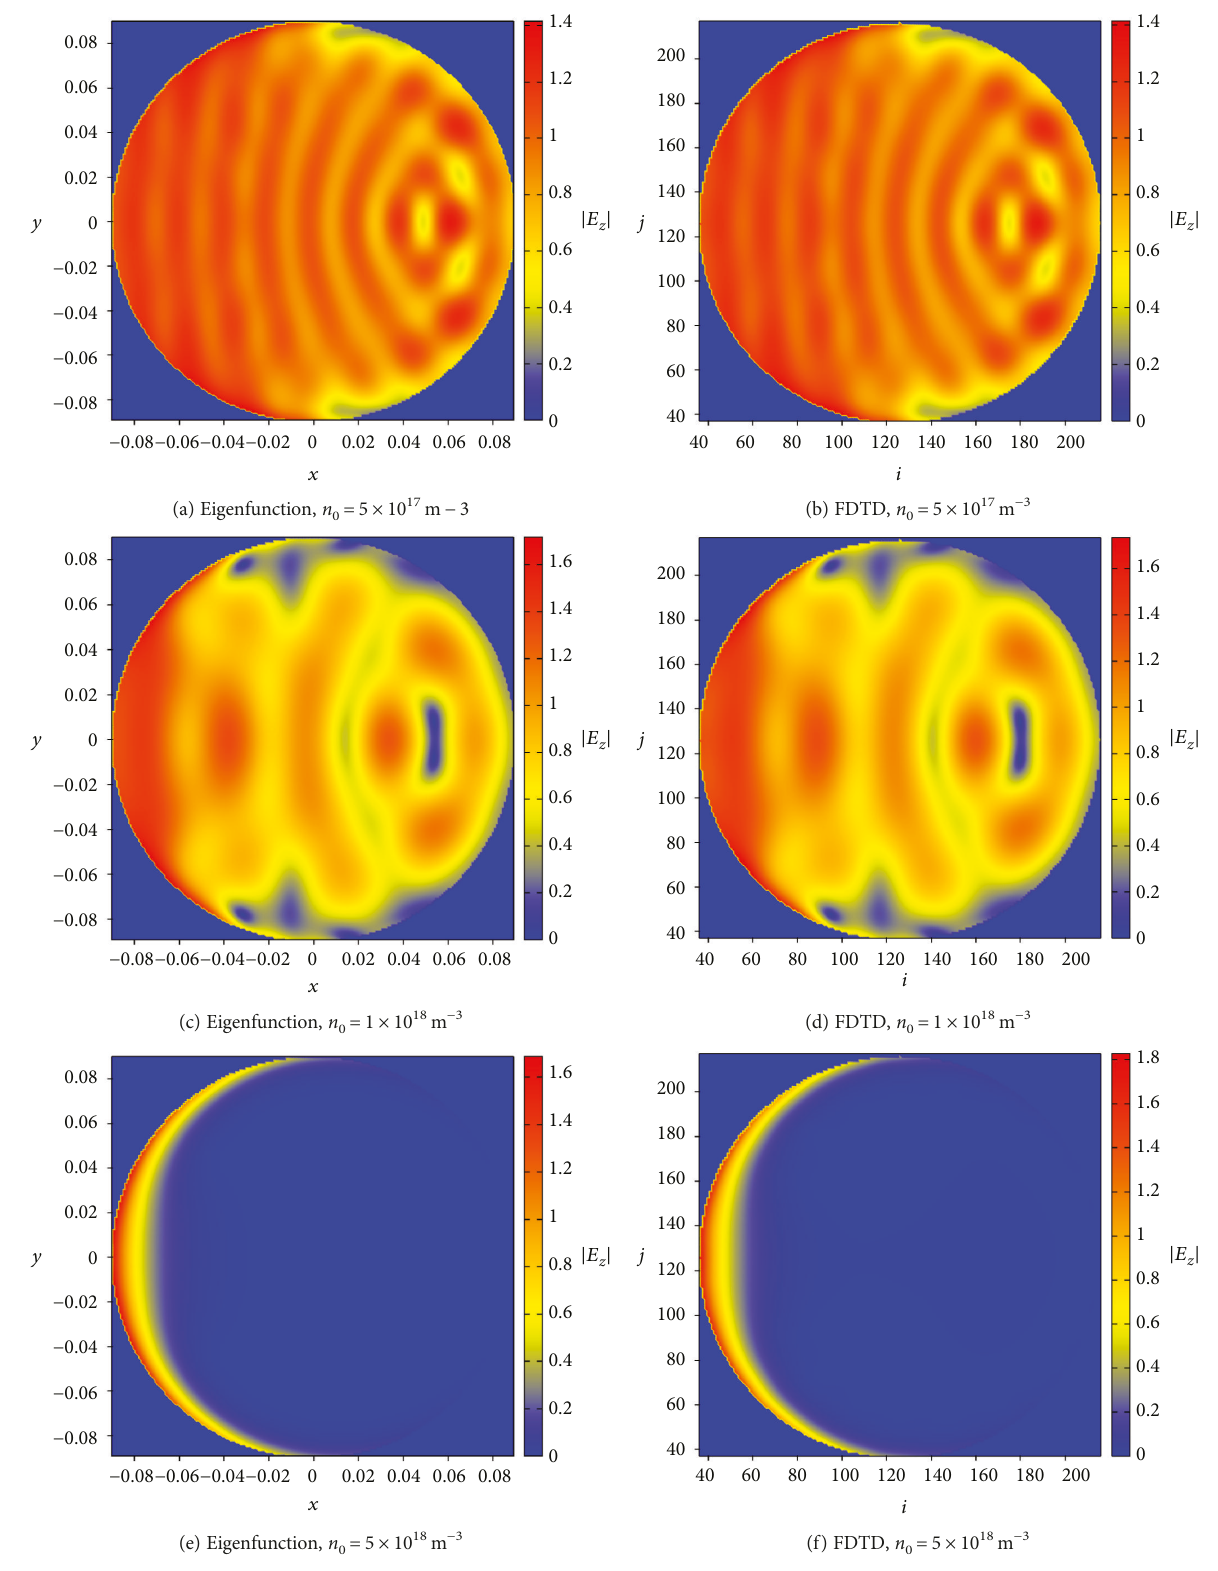
Figure 7: Comparison between the magnitude of the electric fi eld, in volts/meter, within the cylinder obtained by the eigenfunction method and the FDTD simulation for di ff erent electron densities; incident wave frequency is set to f to ν =500 × 10 6